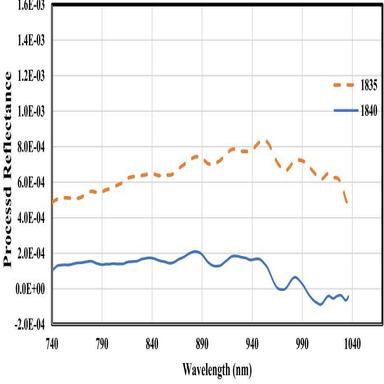
Comparing three SMA mixtures modified with rubber.